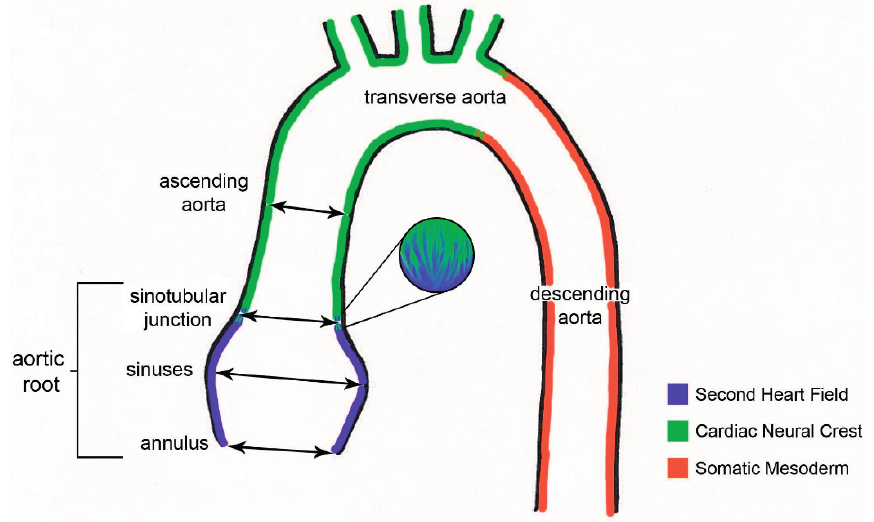
Figure 1. Cell lineages that contribute to the smooth muscle cells lining the ascending, transverse and descending regions of thoracic aorta are shown in schematic [31–34]. Location of echocardiographic measurements of annulus, sinus, and sinotubular junction, and ascending aorta are also